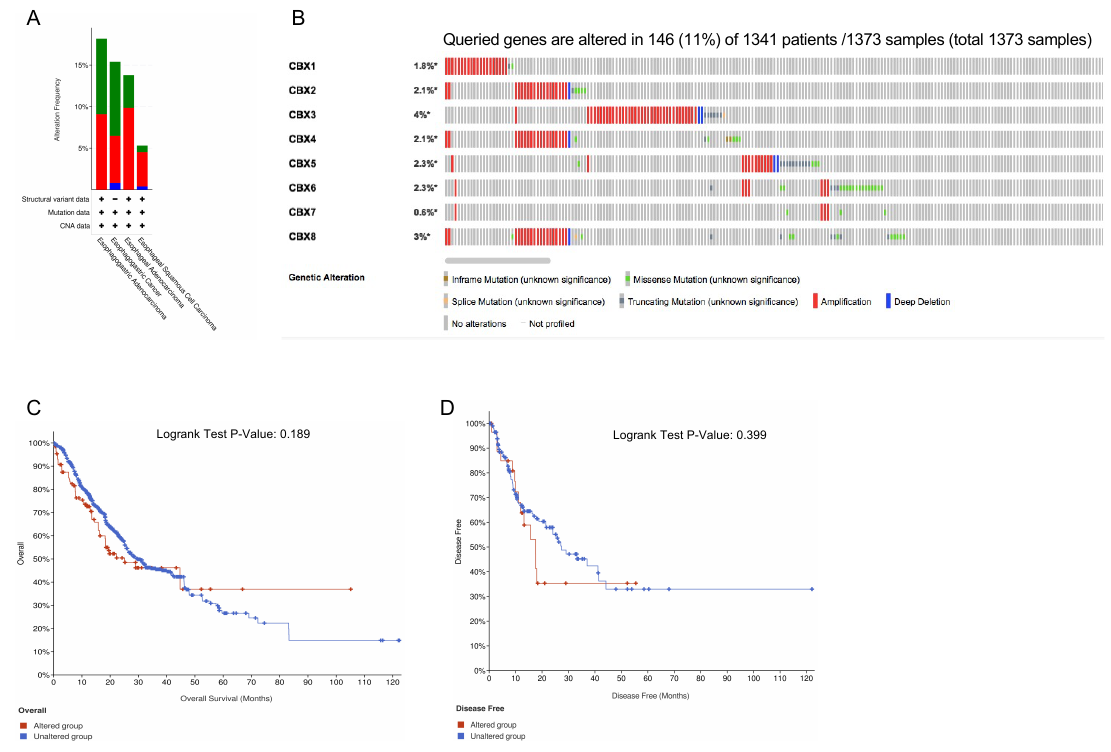
Figure 5. Genetic alterations of CBX family proteins and the related prognostic value in EC. ( A ) Summary of CBXs alterations in EC; ( B ) genetic alterations of CBX family proteins in EC; ( C ) relationship between overall survival (OS) and CBX genetic alterations; ( D ) relationship be- tween disease free survival (DFS) and CBXs genetic alterations. (cBioPortal, p < 0.05 was considered statistically significant).